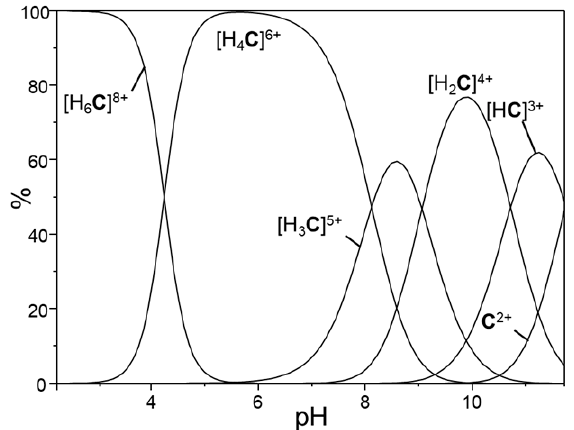
Figure 2. Distribution diagram of the protonated species of complex [Ru(phen) 2 L ] 2+ (the [Ru(phen) 2 L ] unit is indicated with C for clarity).